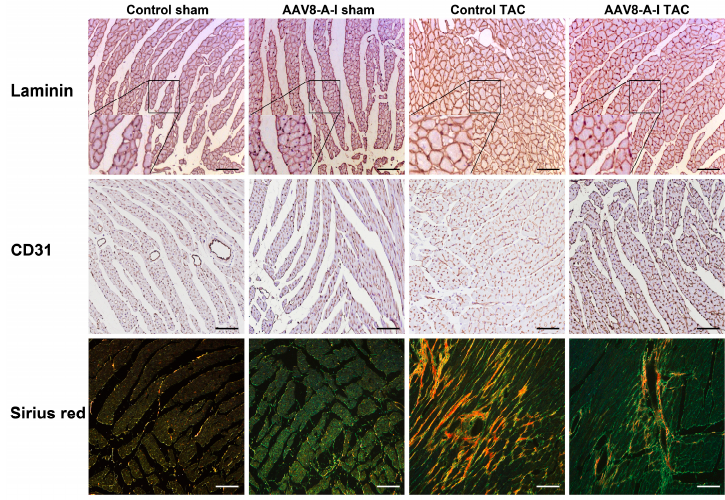
Figure 3. (Immuno)histochemical analysis of the myocardium of sham mice and transverse aortic constriction (TAC) mice at day 56 after operation. Representative photomicrographs show laminin- stained cardiomyocytes, CD31-positive capillaries, and Sirius red-stained interstitial collagen viewed under polarized light. Scale bar represents 50 µm. Insets show a 4× magnification of the boxed region.